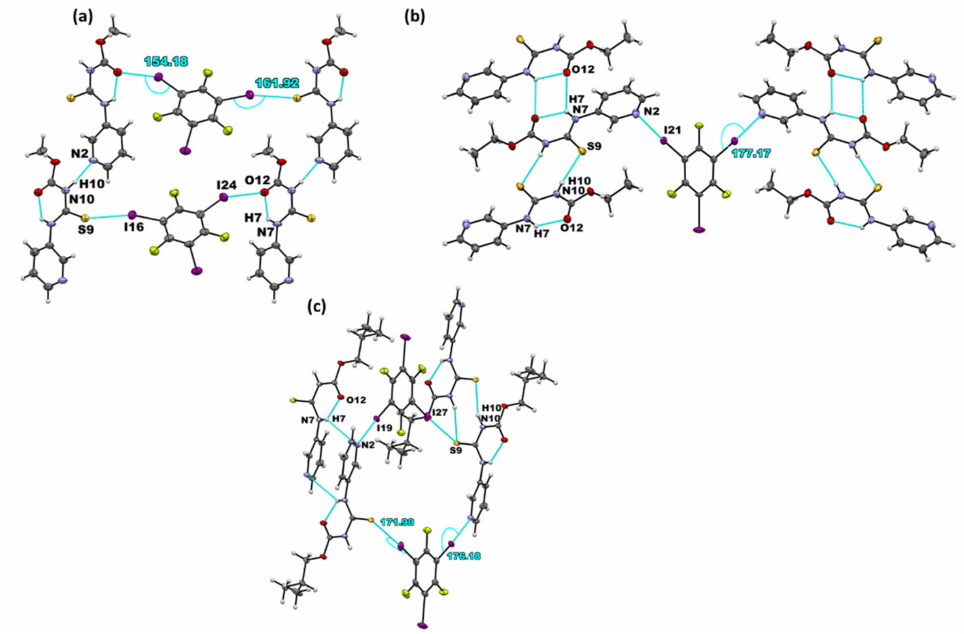
Figure 3. Primary non-covalent interactions (in blue) in the crystal structures of ( a ) A1 · D1 , ( b ) (A2) 2 · D1 , and ( c ) A3 · D1 . The combination of D2 with the R-N-[(3-pyridinylamino) thioxomethyl]